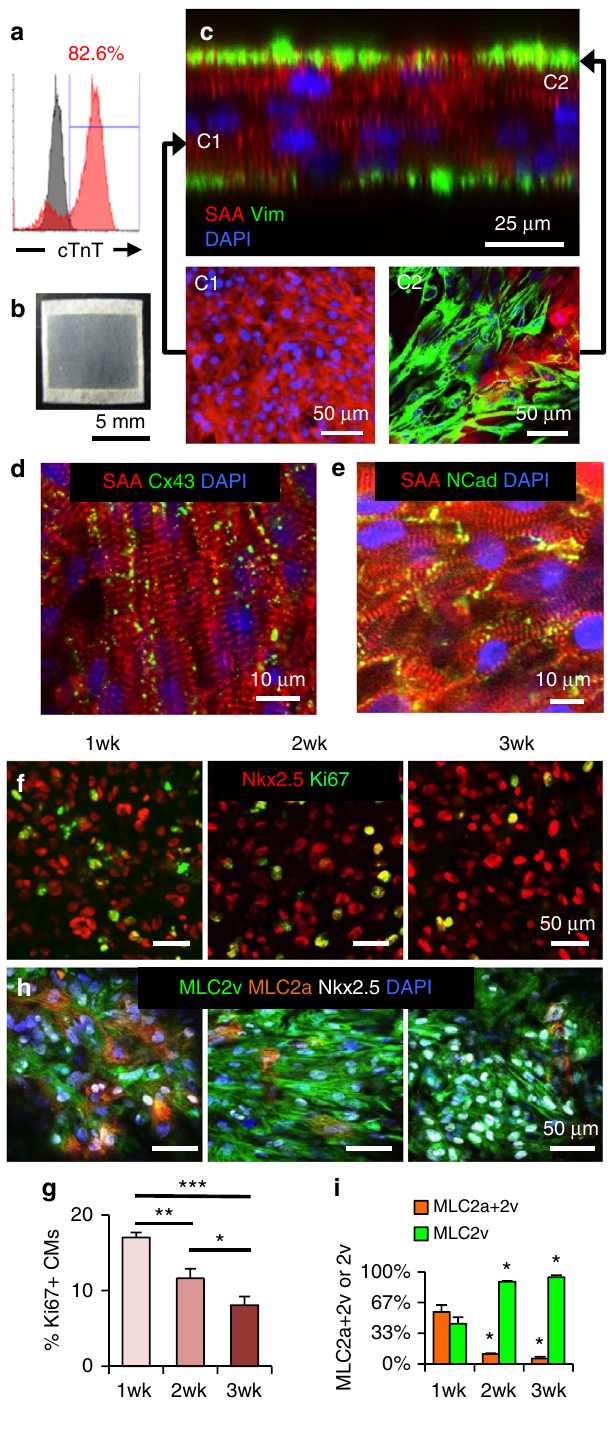
Fig. 1 Structural characterization and maturation of